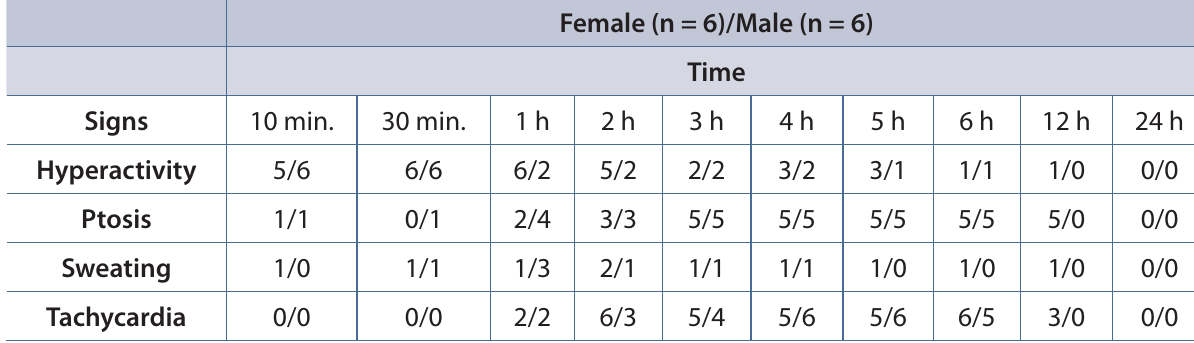
Table 2. Signs observed in 6-week-old female and male mice experimentally envenomed with Tityus serrulatus venom